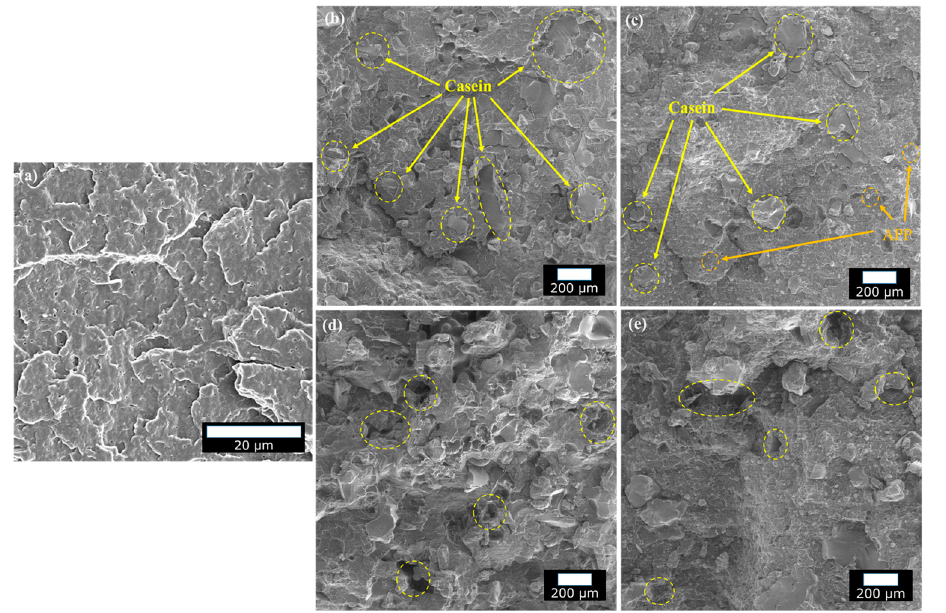
Figure 12. SEM images: cryofractures cross-sections of ( a ) neat PP, ( b ) PP-30LAC, and ( c ) PP-15APP-20LAC, and tensile fractured cross-sections of ( d ) PP-30LAC and ( e )